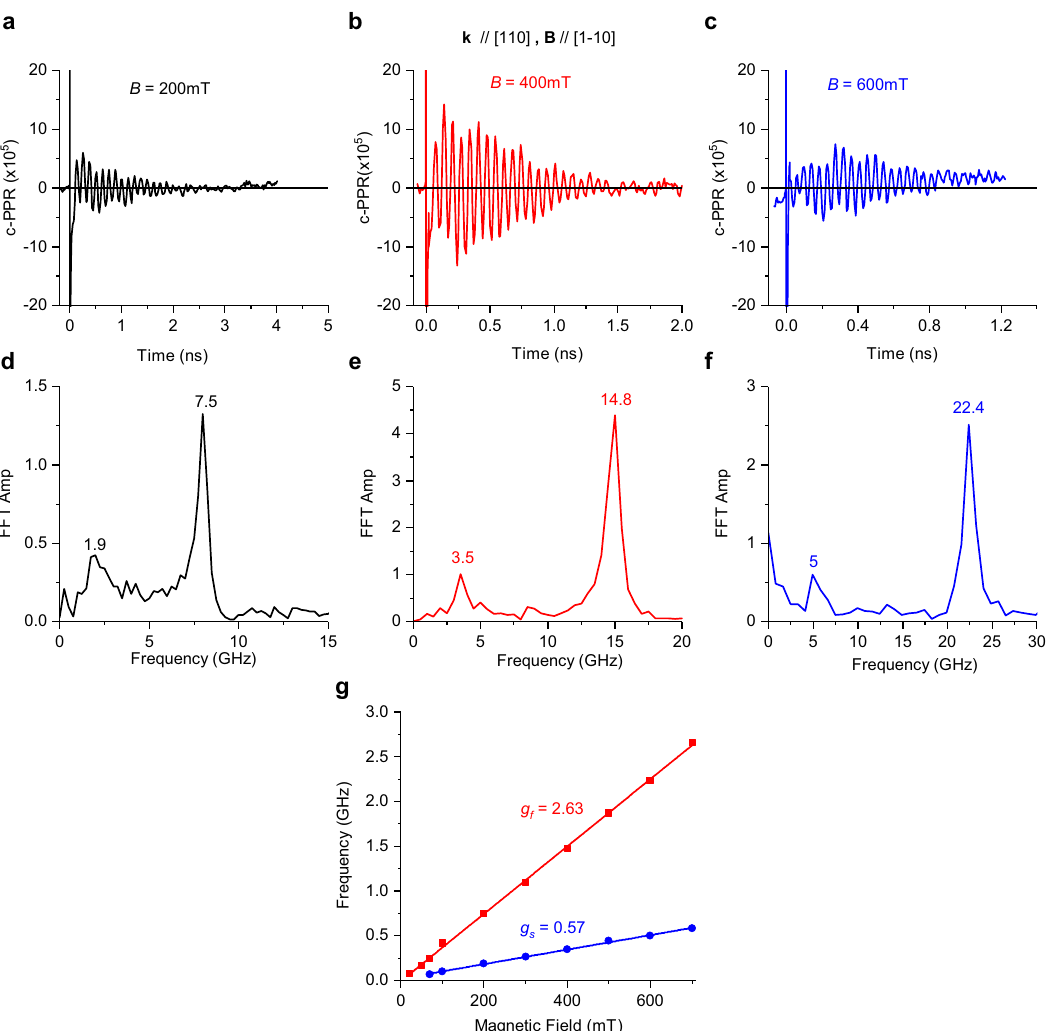
Fig. 3 Photoinduced quantum beatings in MAPbI 3 single crystal at various magnetic- fi eld strengths measured at 4 K with light incident along [110] and applied magnetic fi eld along [1 – 10]. a – c Magnetic- fi eld dependence of the c-PPR(t) response measured at 756 nm pump/probe beams at various fi eld strengths as denoted, and their corresponding FFT spectra d – f . g The corresponding QB frequencies for the fast (red) and slow (blue) beatings vs. B up to 700 mT and the obtained g-values from the various slopes as